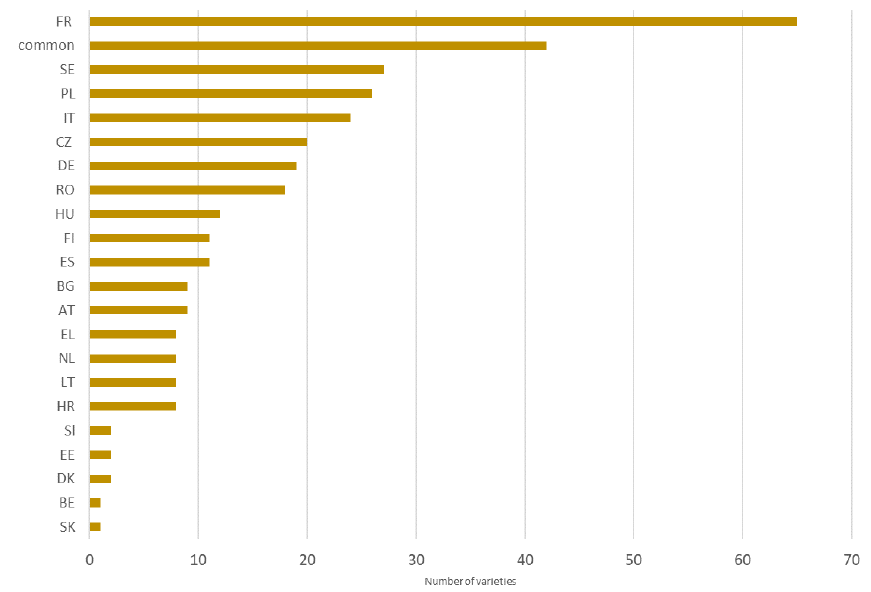
Figure 6. Number of field pea varieties in EU countries [44].